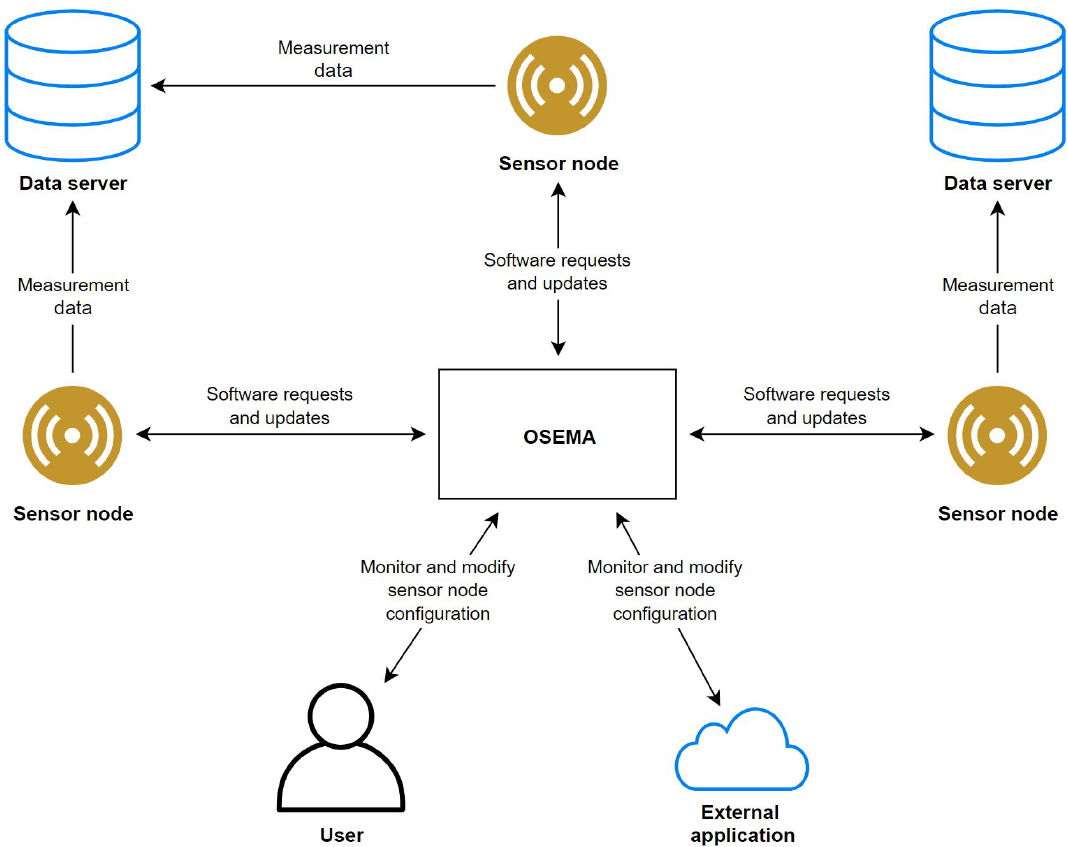
Figure 1. An overview of data collection with the Open Sensor Manager